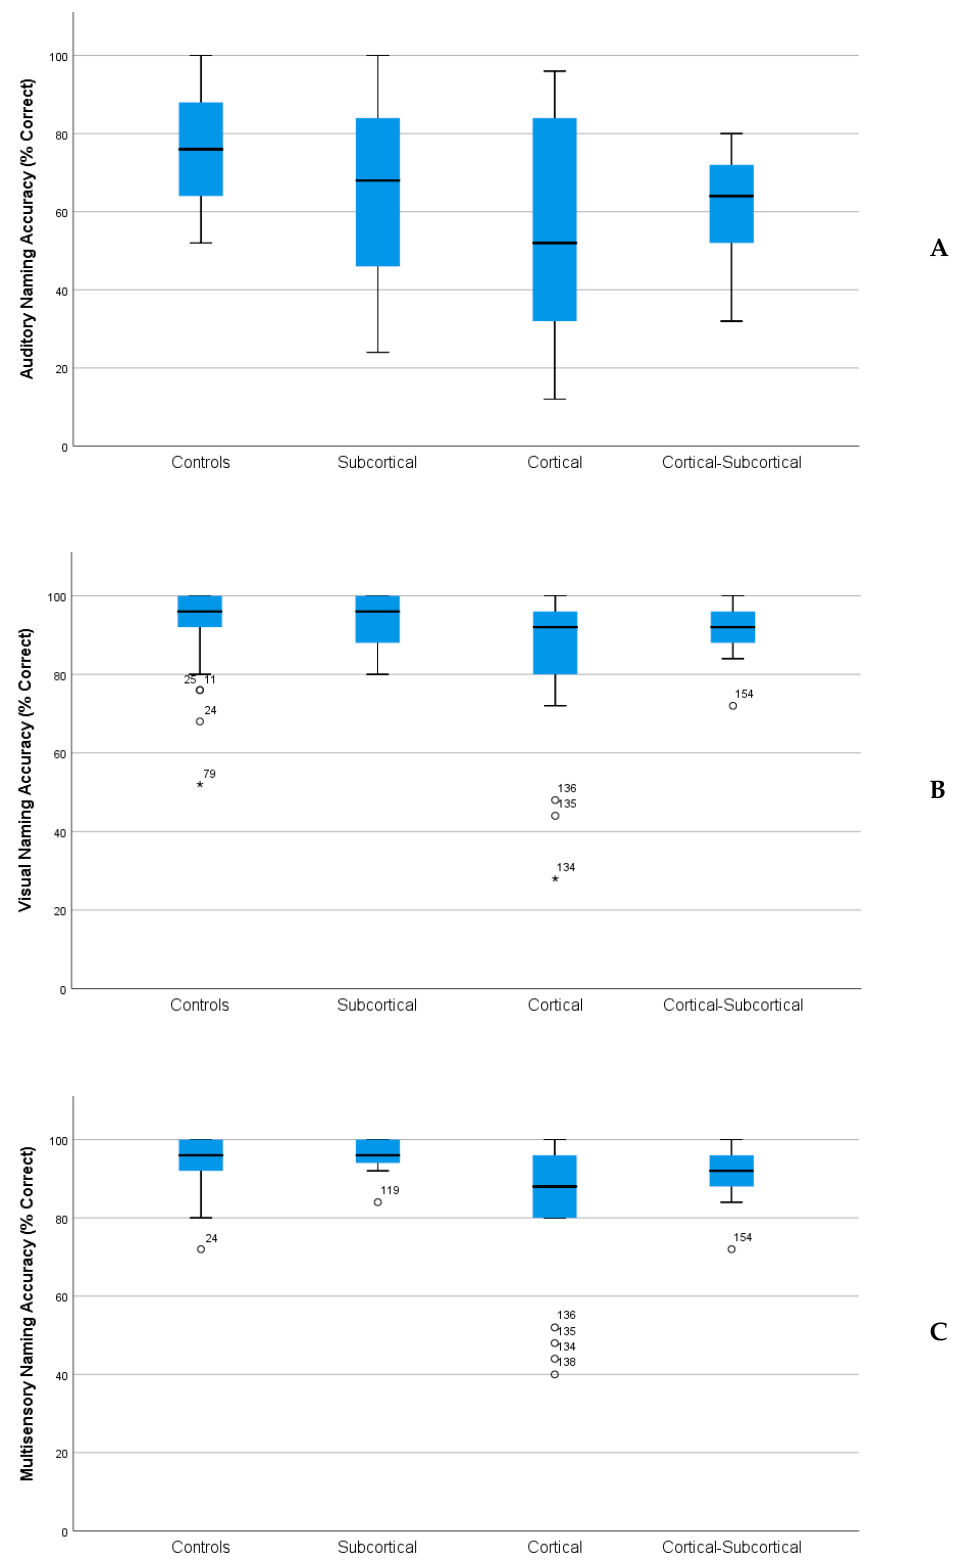
Figure 1. Naming accuracy (% Correct) by group and condition. Box plots depicting median and quartiles, and subject numbers for values extending outside range. A : Auditory naming accuracy by LHD Lesion Group. B : Visual naming accuracy by LHD Lesion Group. C : Multisensory naming accuracy by LHD Lesion Group.